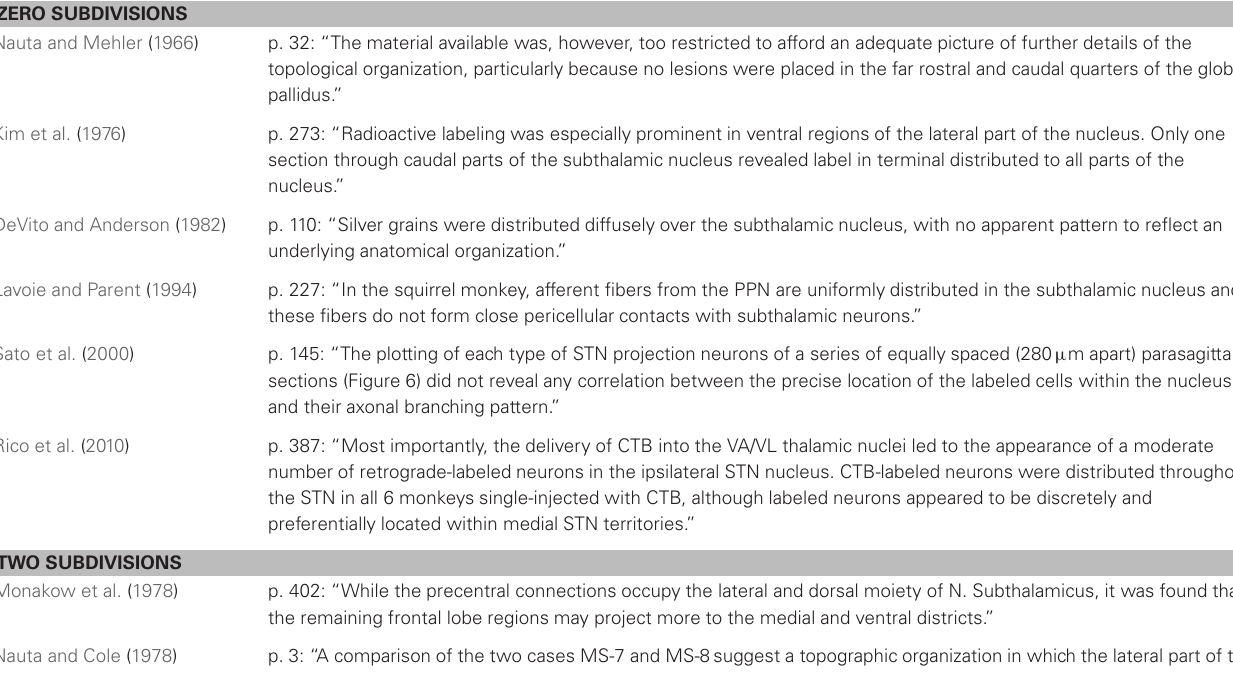
Table 2 | The exact statement or figure number referring to the number of subdivisions derived from all tracings and lesions studies displayed in Figure